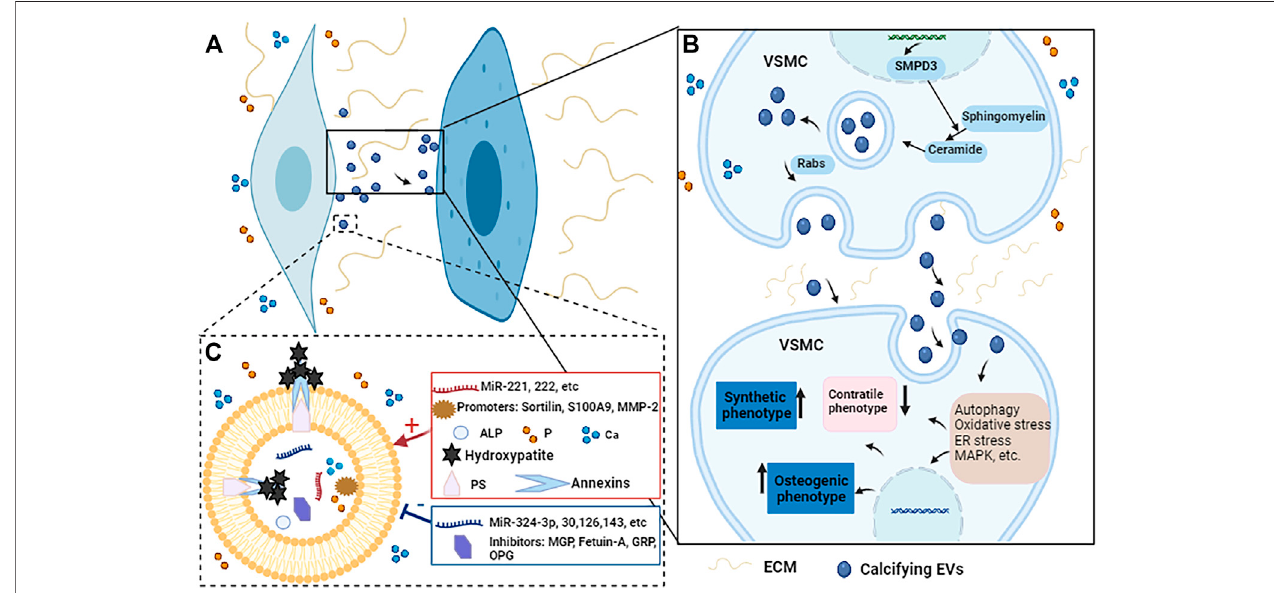
FIGURE 3 | The potential regulatory mechanisms of calcifying EVs regulate the phenotypic switch and osteogenic differentiation of VSMCs during vascular calci fi cation. (A) When VSMCs are exposed to elevated Ca and P conditions, the calcifying EVs it releases act on the recipient VSMCs to change their phenotype and biological function. (B) Under pro-calci fi c milieu, SMPD3 can enhance the secretion of exosomes, which are secreted in a Rabs-dependent manner. Calcifying EVs can regulatethephenotypictransformationandosteogenicdifferentiationofrecipientVSMCsthroughmultiplesignalingpathwayssuchasautophagy,oxidativestress, ER stress, and MAPK, etc. (C) Moreover, the composition of calcifying EVs determines its potential to load hydroxyapatite. When EVs are exposed to high Ca and P conditions,thebalancebetweencalci fi cationpromotersandinhibitorsinEVsisbroken,increasingthecontentofpromoterssuchasCa,P,microRNAs,andannexins.At thesametime,theconcentrationofsomeinhibitorssuchasMGP,fetuin-A,andsomemicroRNAsisreduced.Therefore,themineralconcentrationgradientbetweenthe intra-andextra-vesicular spacesdrivesthein fl uxofPandCaintoEVs via suitabletransporterstoformmineralnucleation sites.TheannexinsandPScomplexesprovide